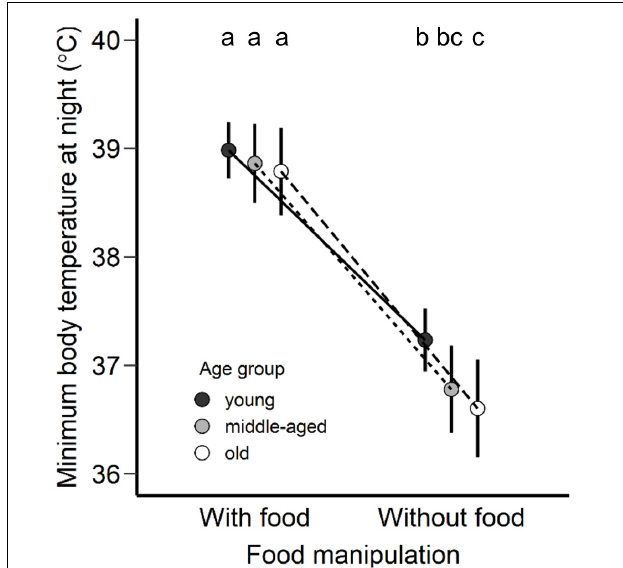
FIGURE 2 | Minimum body temperature at night ( ◦ C) adjusted as least square means for each age group (young, middle-aged, old) of zebra finches with access to food and without food. Points are presented as least square means and error bars represent the 95% confidence intervals. Different letters represent statistical differences after post hoc Tukey’s